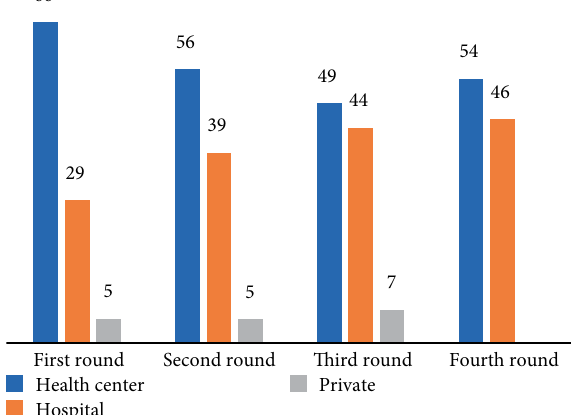
Figure 1: Health seeking behaviour for current medical condition of the study participants ( 𝑛 = 260 ). Types of health facilities visited in each round, % ( 𝑛 = 260 ).